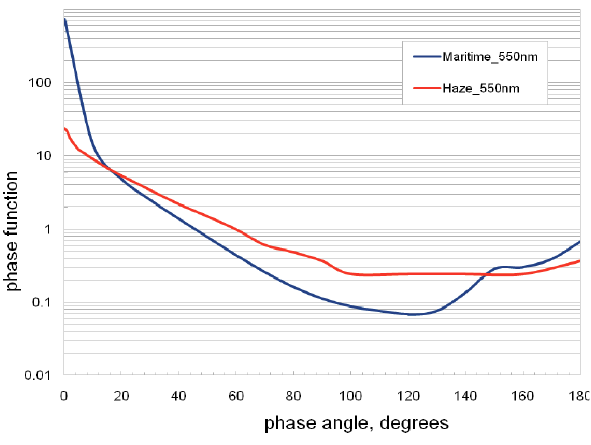
Fig. 2. Phase function of Arctic haze aerosol used in the simulation of aerosol effect on the spectral shape of snow surface. See text for details. 4